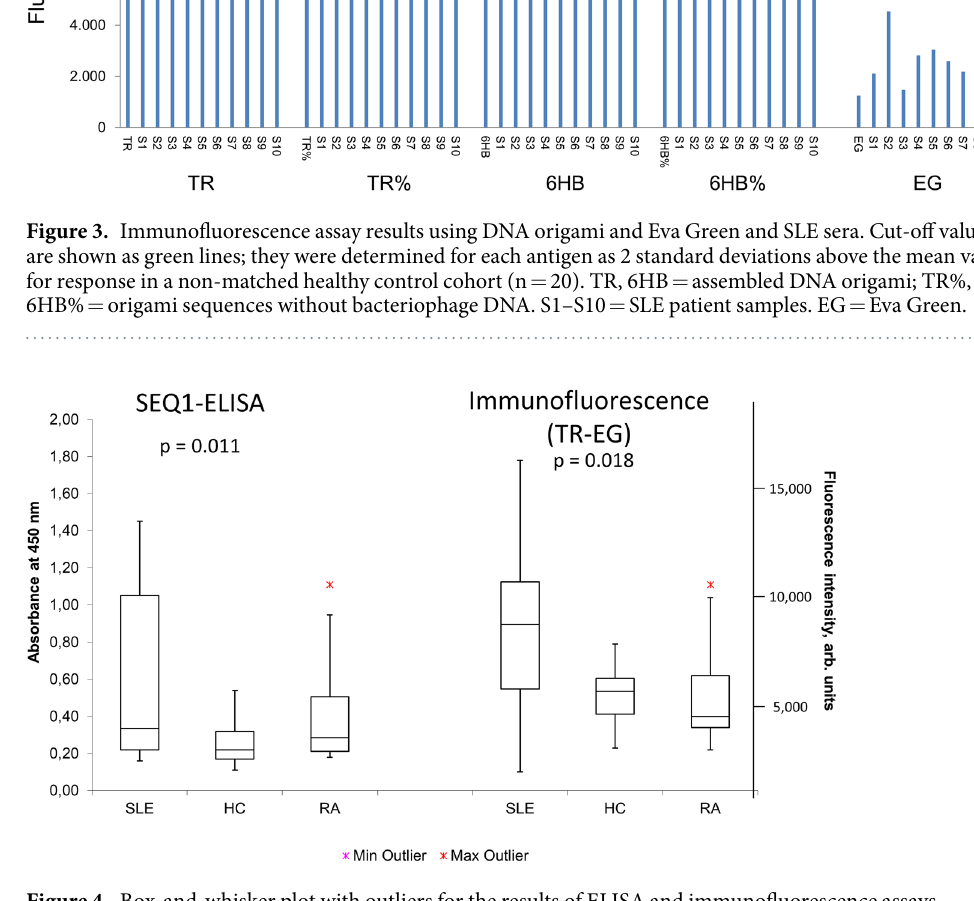
Figure 4. Box-and-whisker plot with outliers for the results of ELISA and immunofluorescence assays performed for SSI samples: SLE (n = 28), HC (n = 20) and RA (n = 20). The arms on each boxplot are values Q 1 –1.5 × IQR and Q 3 + 1.5 × IQR. Data points for each subject are means for three independent measurements. TR-EG = TR origami complex with Eva Green dye. Standard error bars for independent triplicate experiments (n = 3) across antigens are shown in Supplementary Figure